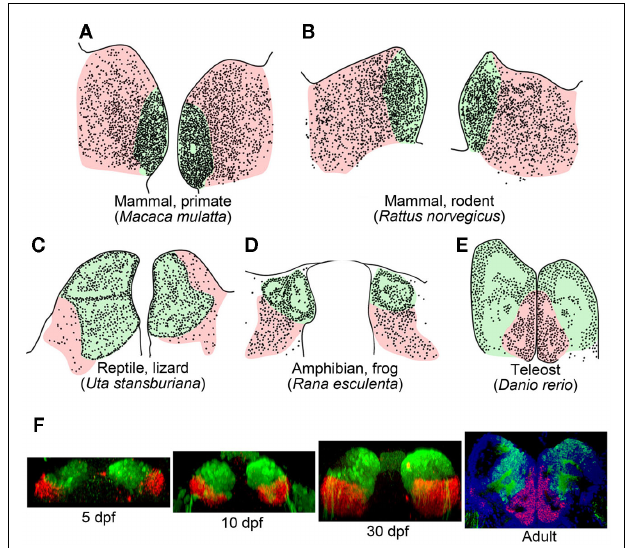
FIGURE 2 | Subnuclear organization of the habenula in vertebrates. (A–E) Schematic drawings of coronal sections taken at the level of the habenula, showing regions homologous to the mammalian medial (light green) and lateral habenulae (pink) of the macaque monkey (A) , rat (B) , side-blotched lizard (C) , European frog (D) , zebrafish (E) .The small dots indicate regions rich in cell bodies, and the remaining gaps are neuropils. (A,B) were adapted from Amo et al. (2010). (C,D) Schematics modified from data presented previously by Guglielmotti and Fiorino (1998) (D) and Engbretson et al. (1981) (C) . (E) Schematic drawing based on a coronal section of adult zebrafish stained with cresyl violet. (F) Development of the ventral habenula, based on expression patterns of the ventral habenular marker, diamine oxidase . Coronal views ofTg( brn3a-hsp70 : GFP ) zebrafish showing the distributions of dao -expressing cells in the ventral habenula (red) and GFP-expressing cells in the medial subnucleus of the dorsal habenula (green). Developmental stages are indicated beneath each panel. A section of adult zebrafish habenula (rightmost panel) was counter-stained by 4 (cid:2) ,6 (cid:2) -diamidino-2-phenylindole (DAPI; blue). dpf, Days